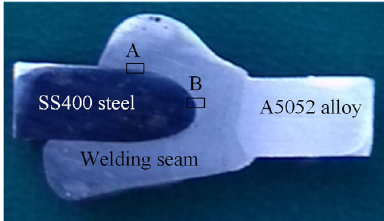
Figure 2. Macrographs of MIG welds between A5052 aluminum alloy and SS400 steel where A and B are micro-hardness testing IMC layer area and micro-hardness testing without IMC area, respectively.